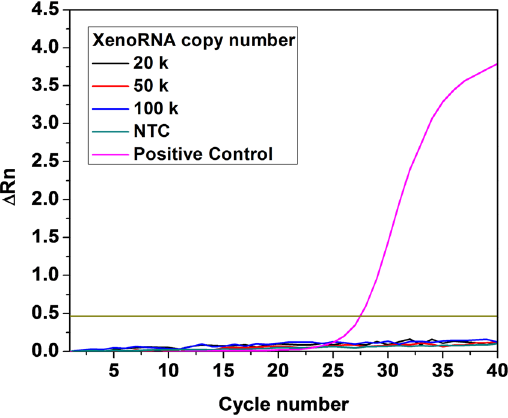
Figure 1. Quantified detection of RNA trapping efficiency using 3.5 × 10 6 beads. There was no detectable residual XenoRNA template in the binding waste.